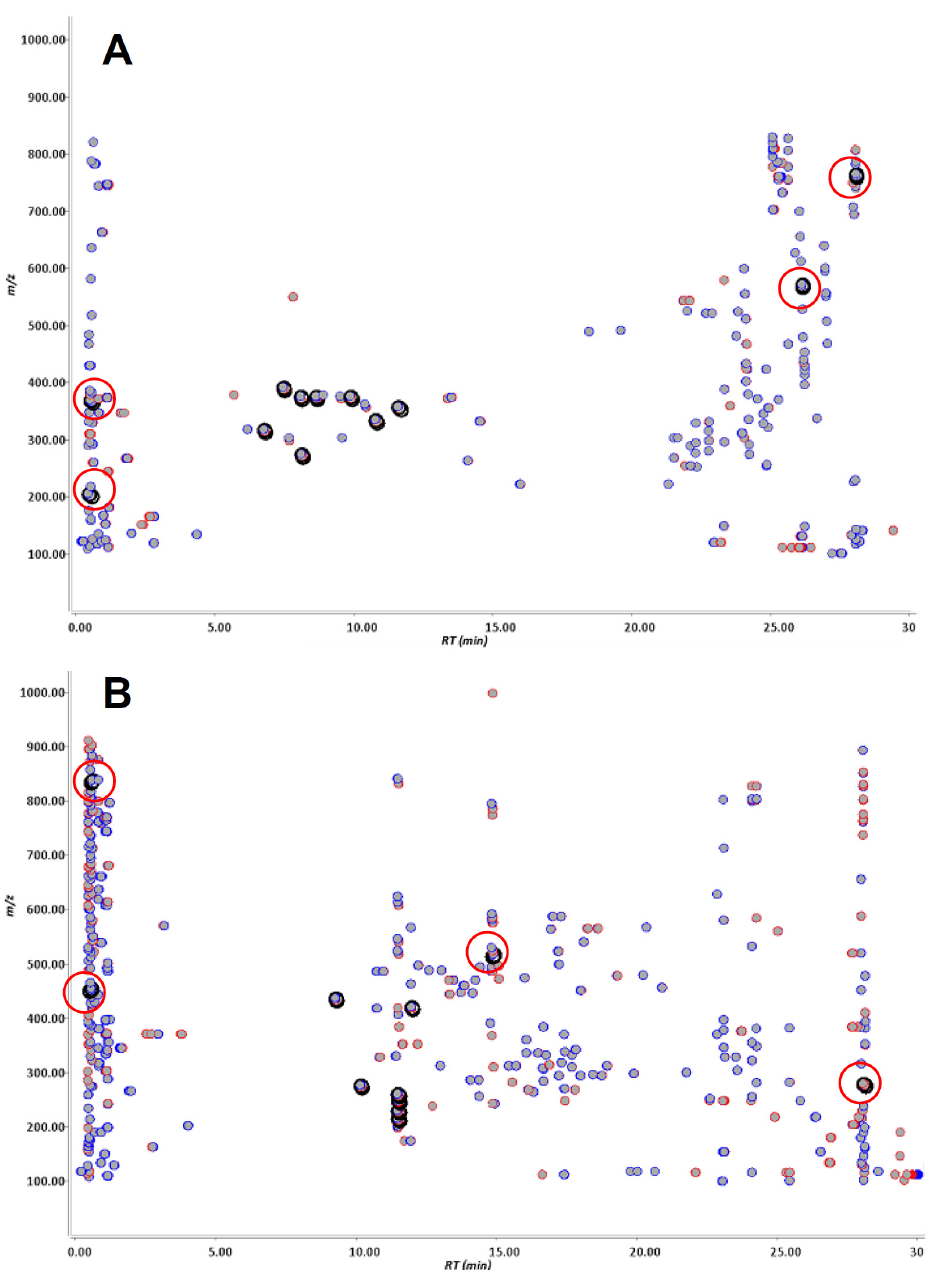
Figure 5. Ions detected by stable isotopic mass-shift filtering between deuterium-labeled and un-labeled compounds in pioglitazone ( A ) and flurbiprofen ( B ) metabolized in human liver microsomes. The ions derived from un-labeled and labeled compounds are shown in red and blue, respectively. By comparing un-labeled ( red ) and labeled ( blue ) compounds, the particular ions having a specific mass-shift equal to 4 ± 0.5 Da for pioglitazone and 3 ± 0.5 Da for flurbiprofen were computationally filtered and visualized by being circled in black. The ions, estimated as non-metabolites, were manually marked in red